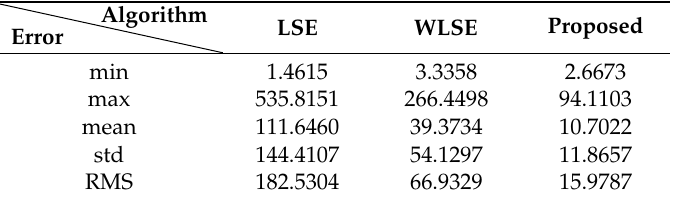
Table 5. Analysis of position errors from three algorithm for moving scenario.